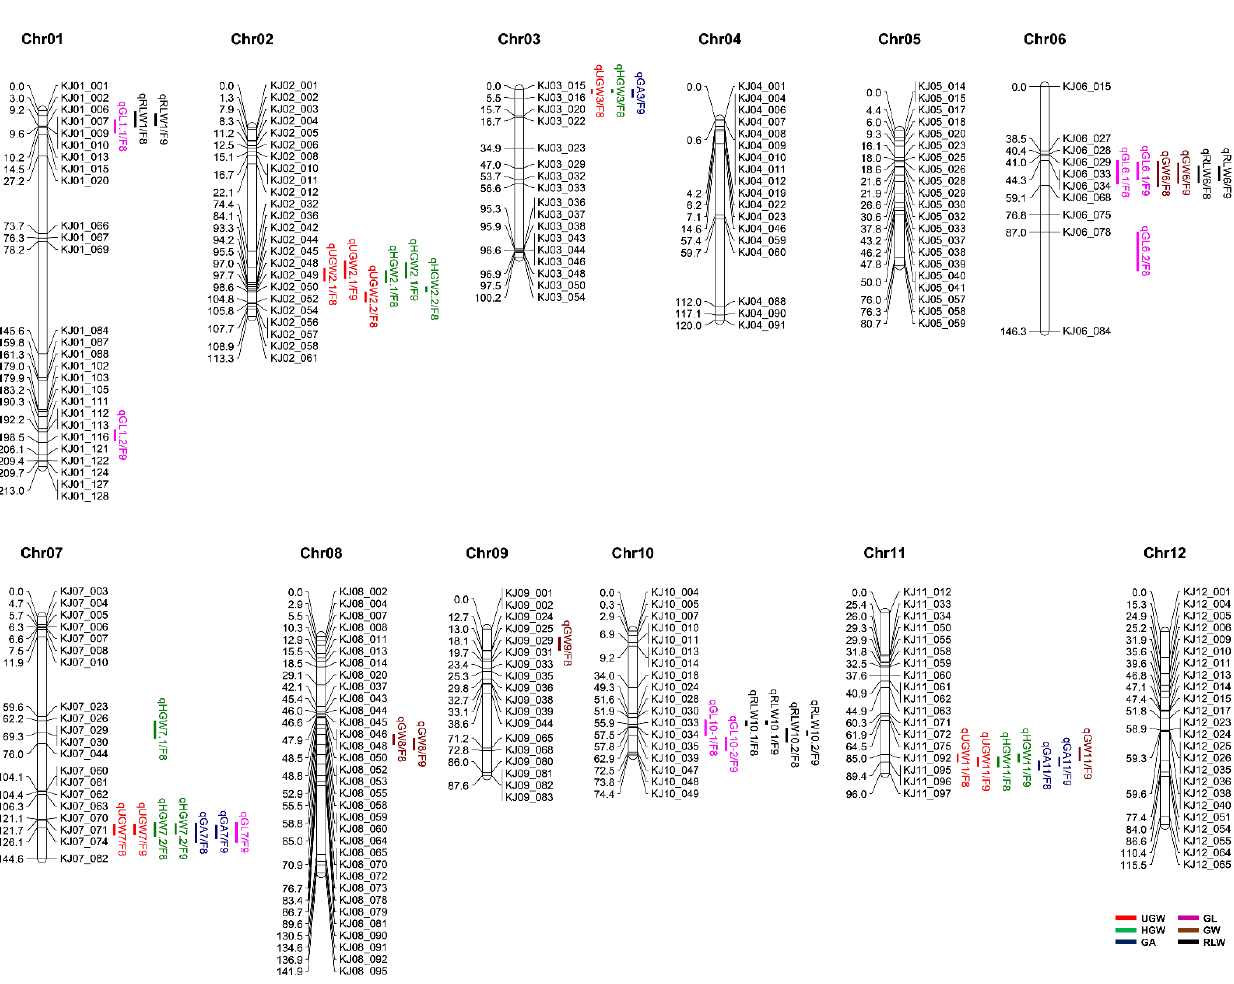
Figure 2. Genetic map showing the chromosomal distribution of grain size-related QTLs in the RIL population ( n = 162) derived from a cross between Odae and Joun. Chromosome numbers (Chr01–12) are indicated above each chromosome. Numbers on the left side of each chromosome represent the position of markers in centimorgan (cM), and IDs on the right side of each chromosome represent the KASP marker names. QTLs (vertical text) are indicated on the right side of each chromosome, at the corresponding genetic map position, and the text following a slash (/) indicates the generations of the population grown in 2019 (F 8 ) and 2020 (F 9 ).